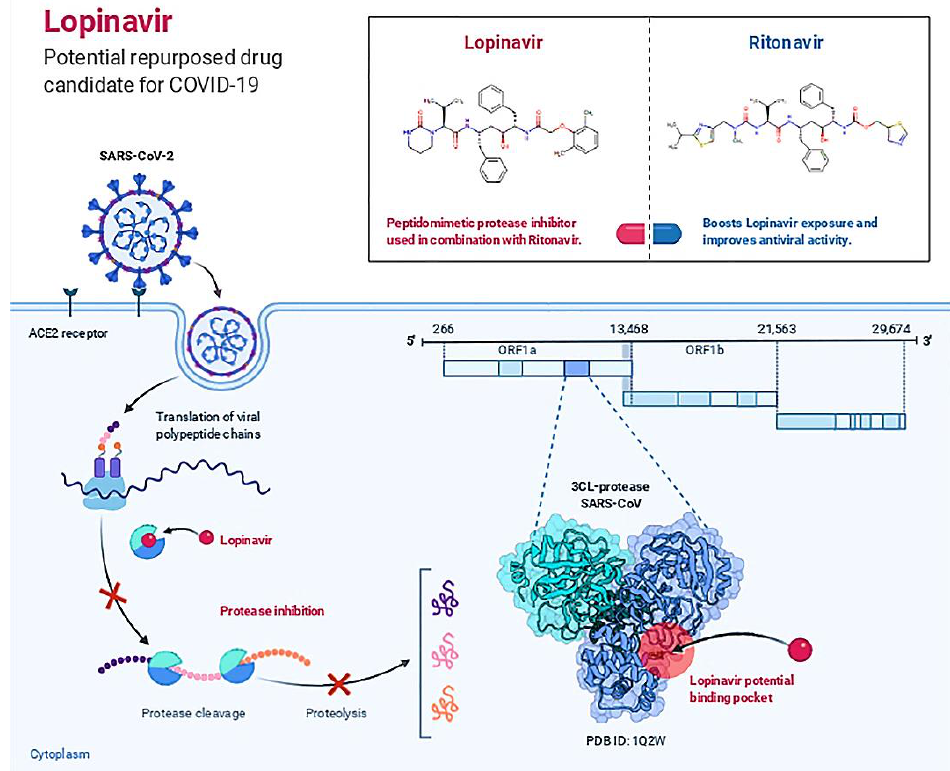
Figure 6. Lopinavir: Potential Repurposed Drug Candidate for COVID-19.